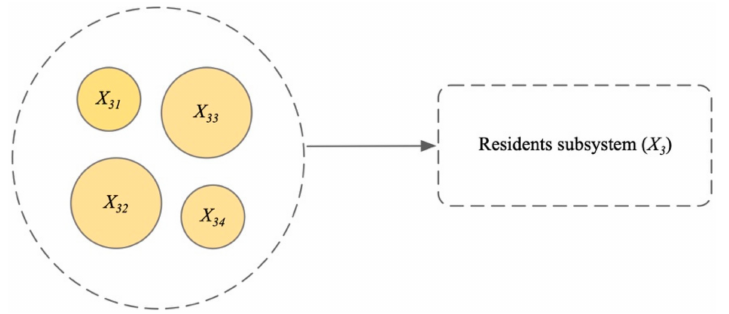
Figure 6. Indicators interaction in residents